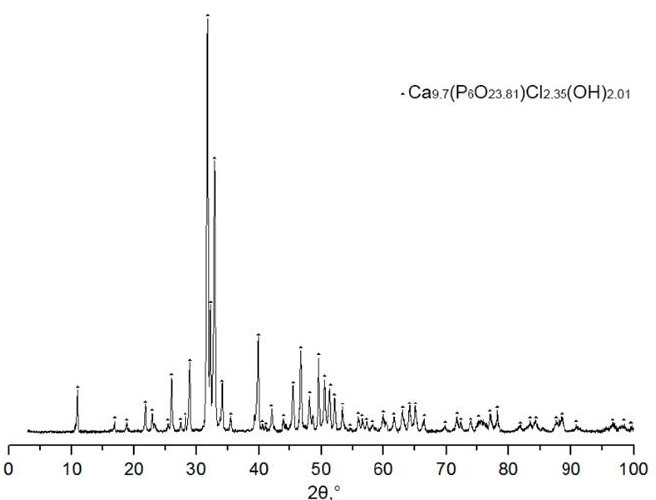
Figure 3. Diffractogram of HA (75) after calcination HA with NaCl.